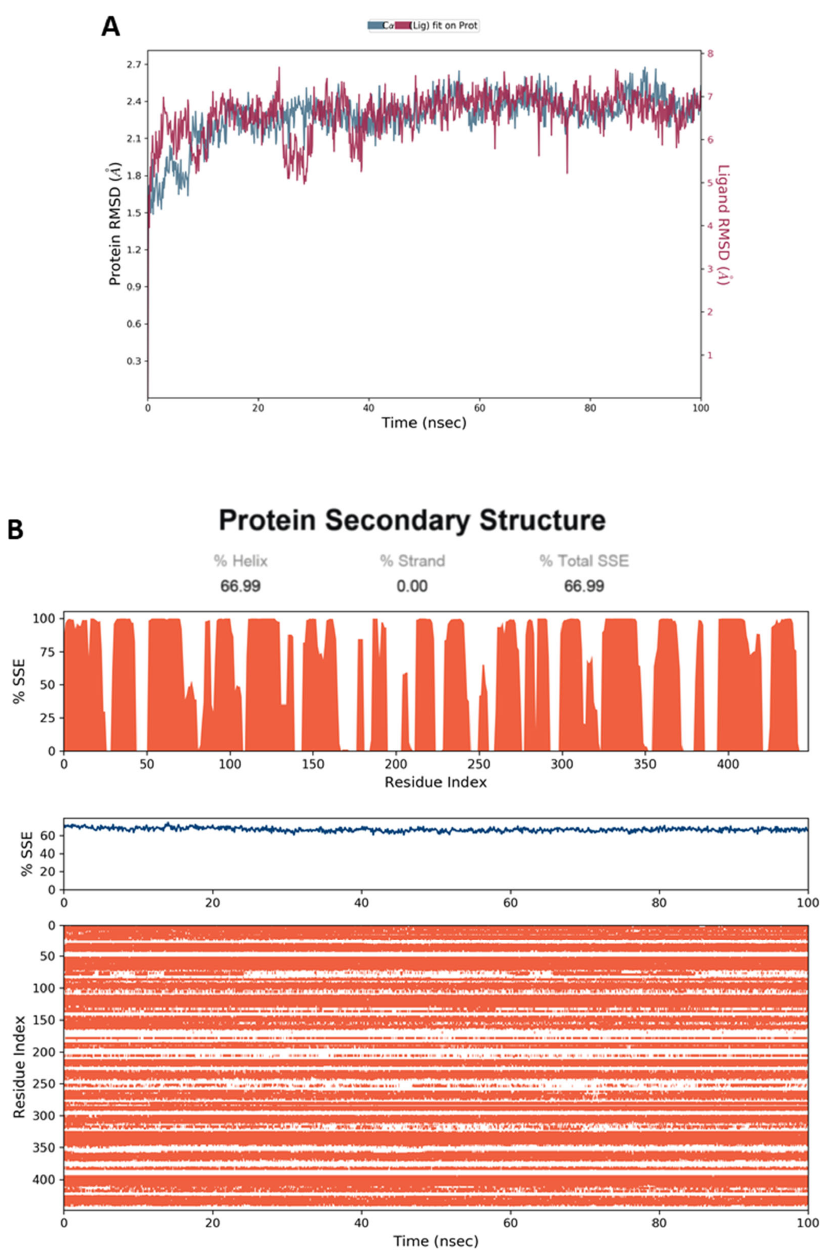
Figure 18. ( A ) RMSD graph for the native inhibitor 5RE, complexed with the GLUT1 protein (PDB ID: 5EQG). The simulation time (100 ns) confirmed the stability of the complex, with no significant changes in the protein structure. ( B ) Stability of the secondary structure GLUT1 protein (PDB ID: 5EQG) throughout the MD simulation when complexed with 5RE . Protein secondary structure elements (SSE) were monitored during the simulation. The upper plot presented the SSE distribution by residue index across the protein structure. The middle plot summarized the SSE composition for each trajectory frame throughout the simulation, and the plot at the bottom monitored each residue and its SSE assignment over the simulation time.